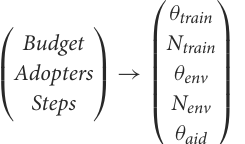
from the population is the fraction of adopters. The decision steps remaining before time limit are included to provide time-awareness in the state representation, an approach that has proven good results in time-limited domains